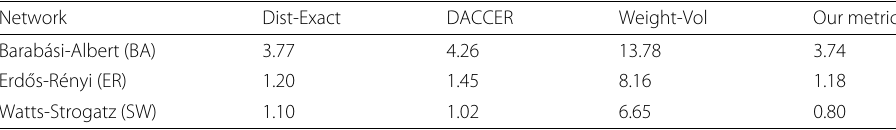
Table 6 Running time (in milliseconds ) comparison for different local metrics on synthetic networks in a simulated distributed environment Network Dist-Exact DACCER Weight-Vol Our metric Barabási-Albert (BA) 3.77 4.26 13.78 3.74 Erd˝os-Rényi (ER) 1.20 1.45 8.16 1.18 Watts-Strogatz (SW) 1.10 1.02 6.65